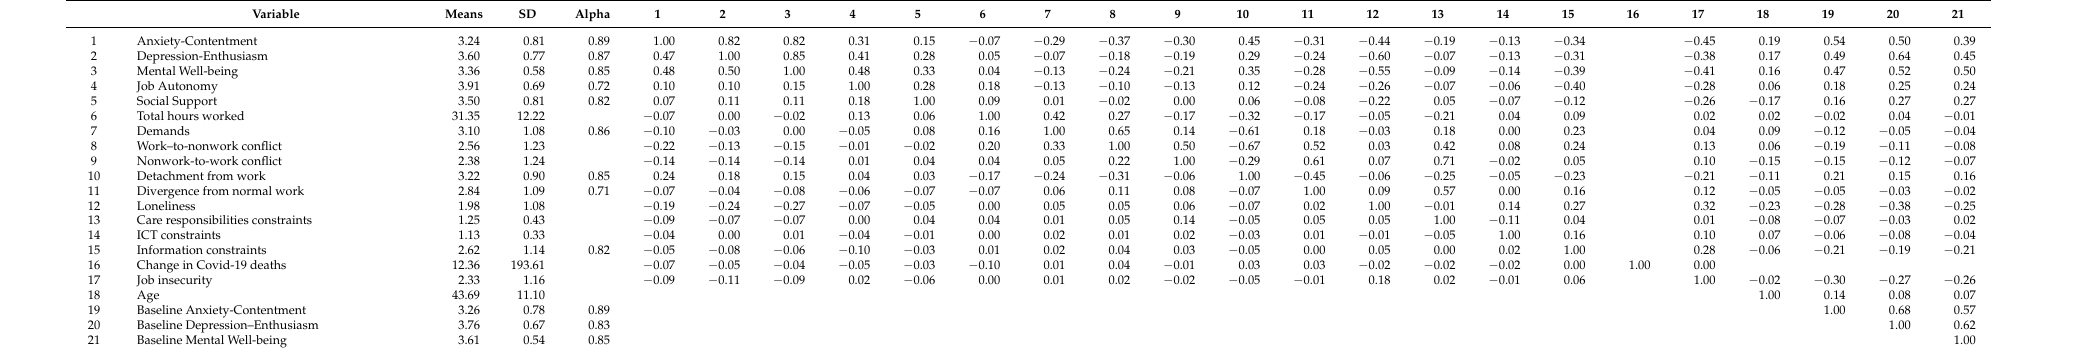
Table 2. Descriptive Statistics and Correlations for Phase 1.